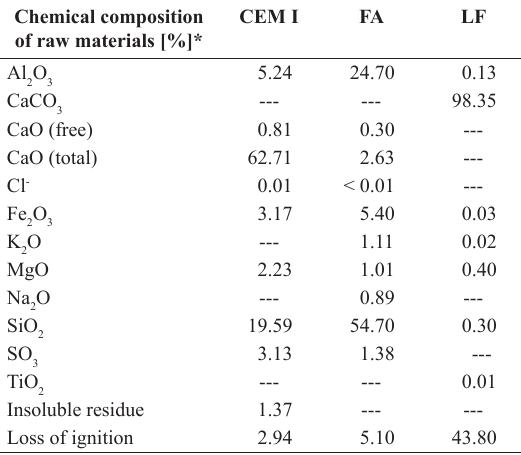
Table 1. Chemical composition of raw materials.